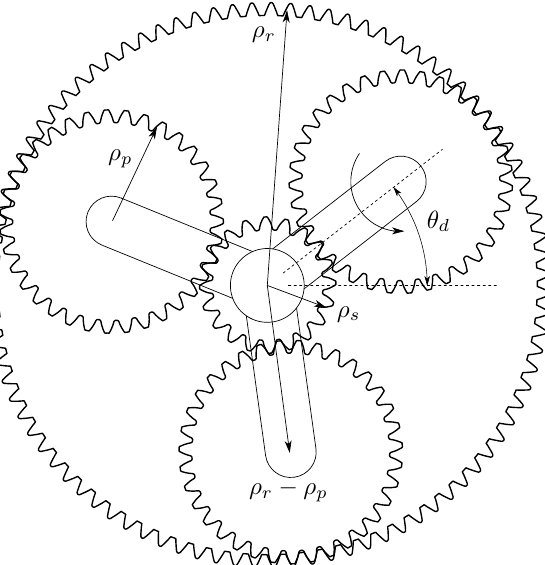
Figure 5: Planetary gearbox with radii for sun ρ s , planet ( ρ p ) and ring ( ρ r ) gears. Planetary carrier (driver) angle is θ d